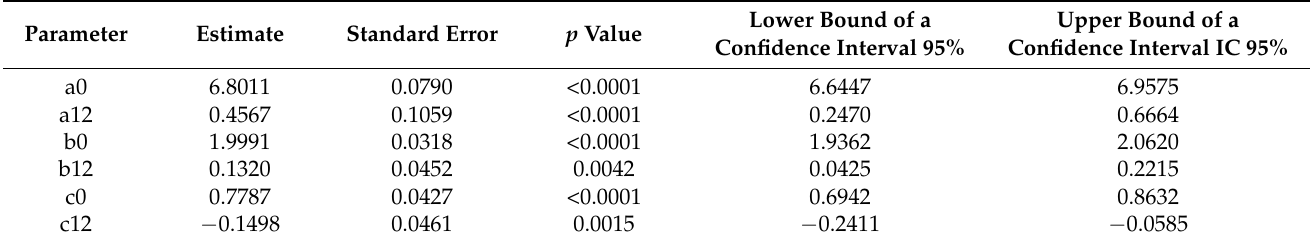
Table 4. Estimation of the parameters of the dry mass allocation model between the shoots and the roots of white spruce seedlings (1 + 0) depending to the cover treatments.